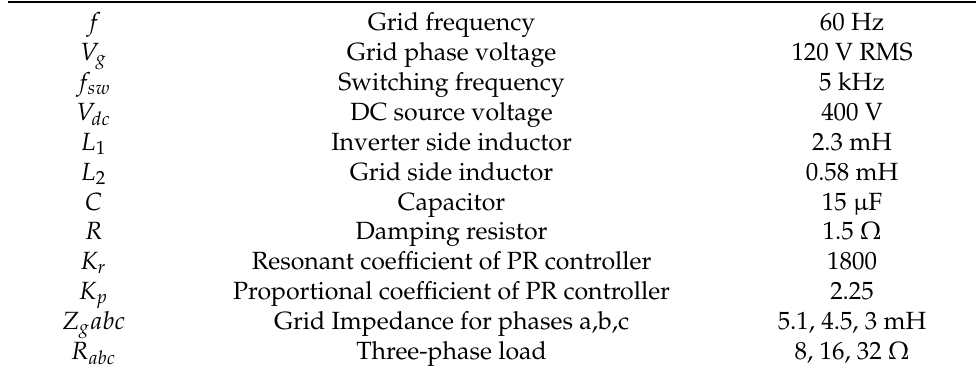
Table 1. Experimental System